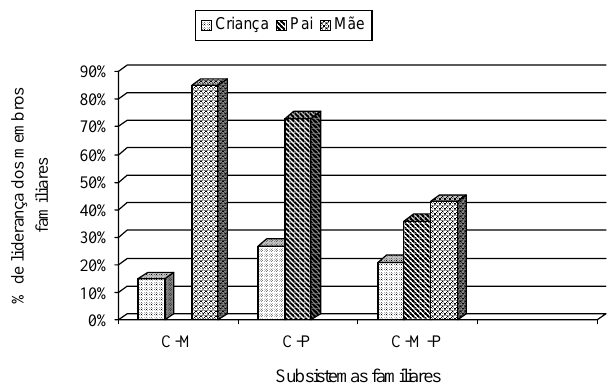
Figura 5. Lideran(cid:231)a exercida pelos genitores e pela crian(cid:231)a, durante epis(cid:243)dios de intera(cid:231)ªo diÆdicos e